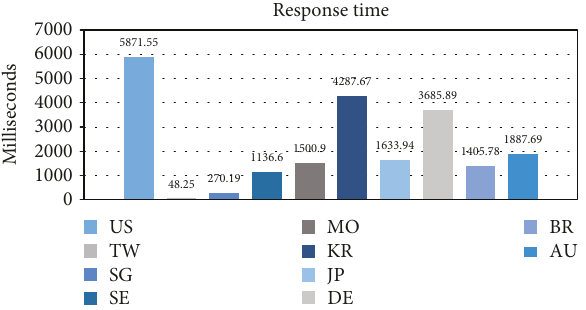
Figure 5: Geographical measurements of the blanket mode (response time).